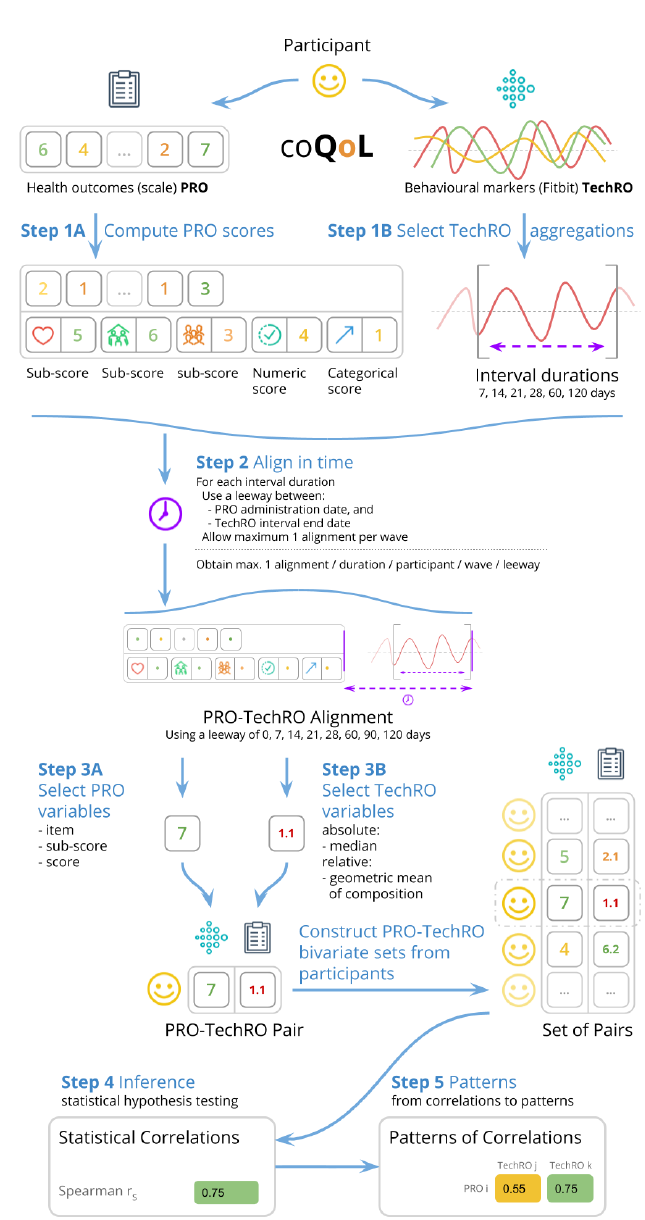
Figure 1. coQoL: a method for PRO and TechRO co-calibration (example for MSPSS